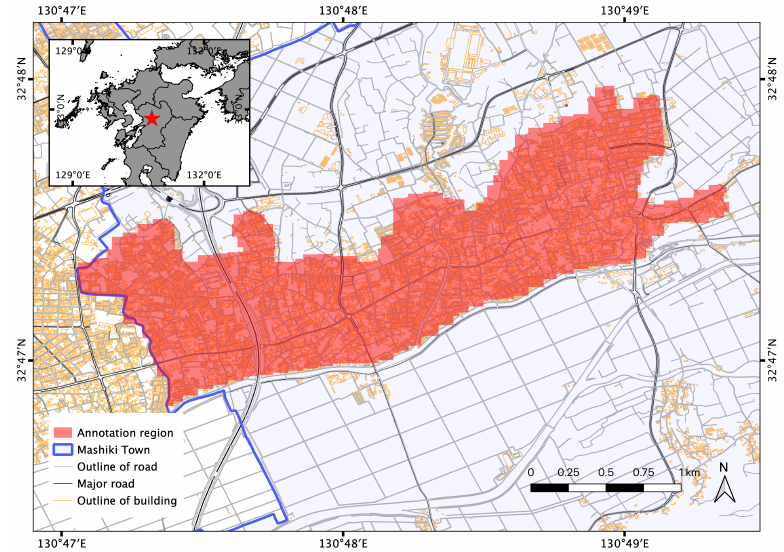
Figure 2. The central area of Mashiki Town is chosen as the study area of this study, which is shown as the red shaded area. The residential buildings in this area were densely distributed and severely damaged by the 2016 Kumamoto